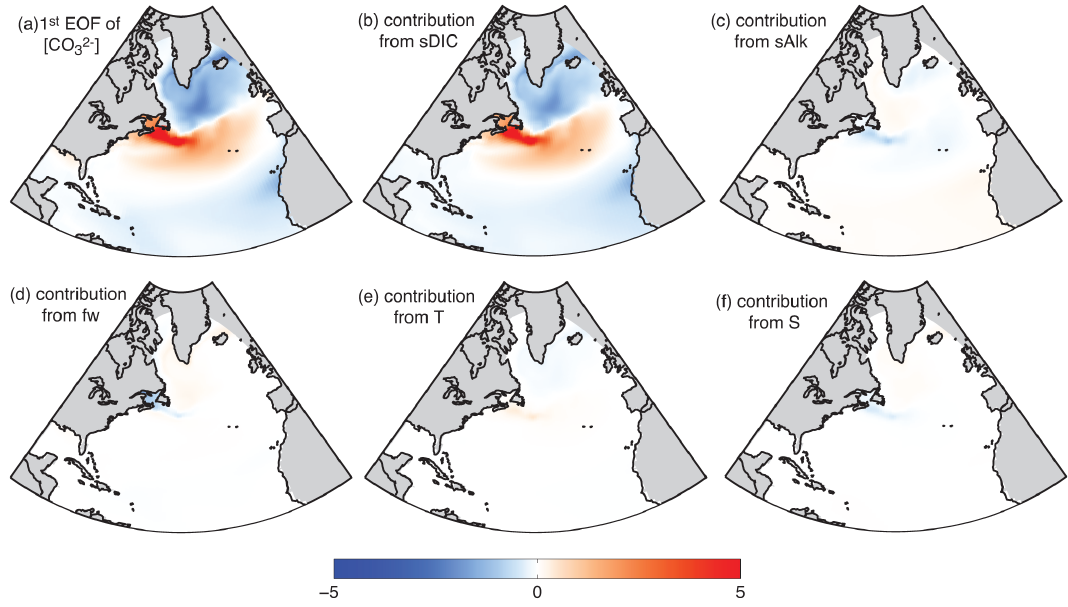
Figure 10. As in Fig. 7, but for the North